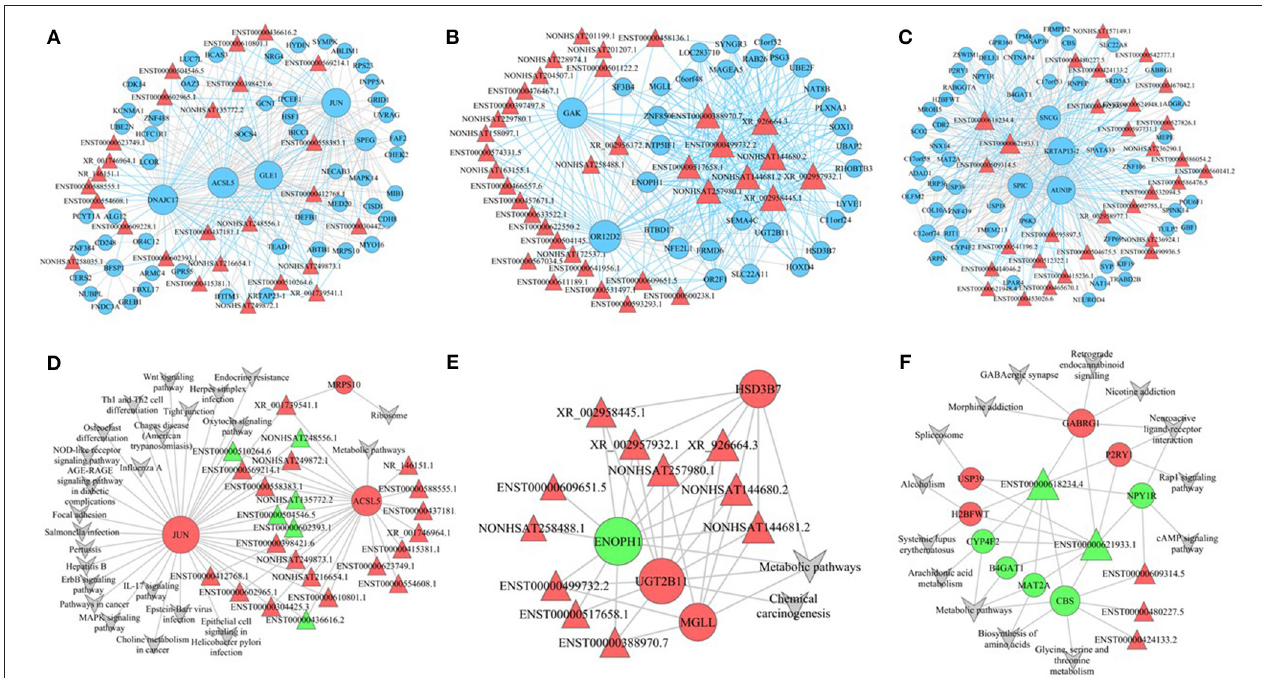
FIGURE 7 | Established lncRNA–mRNA network and lncRNA–mRNA pathway. (A–C) lncRNA–mRNA network of genes in blue (A) , brown (B) , and turquoise (C) modules. (D–F) lncRNA–mRNA pathway of genes in blue (D) , brown (E) , and turquoise (F)